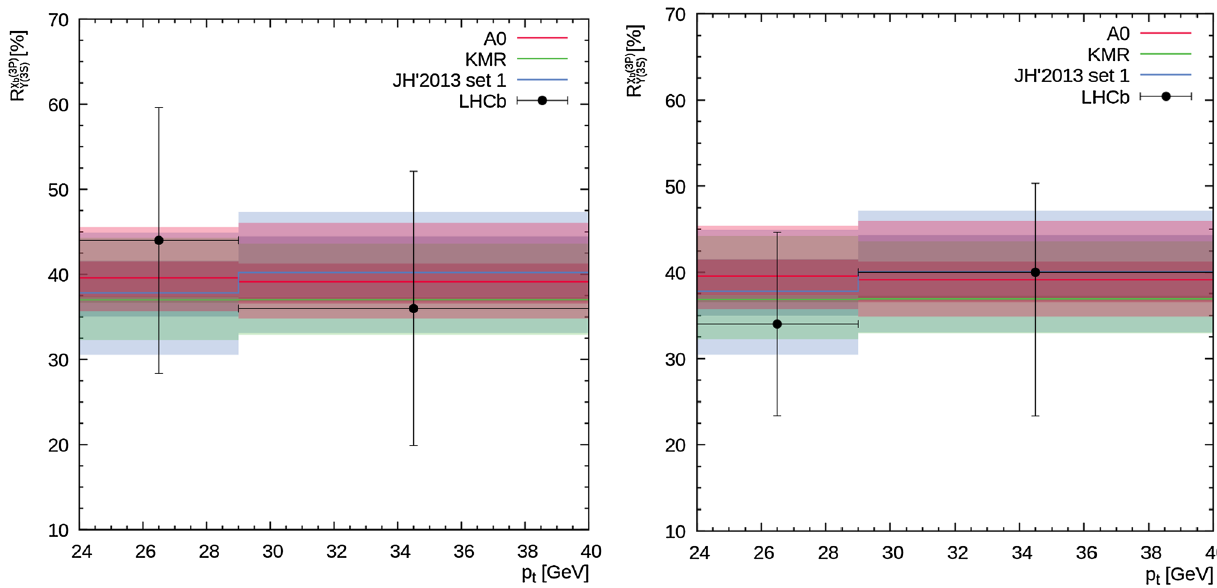
√ s = 7 TeV (left panel) and